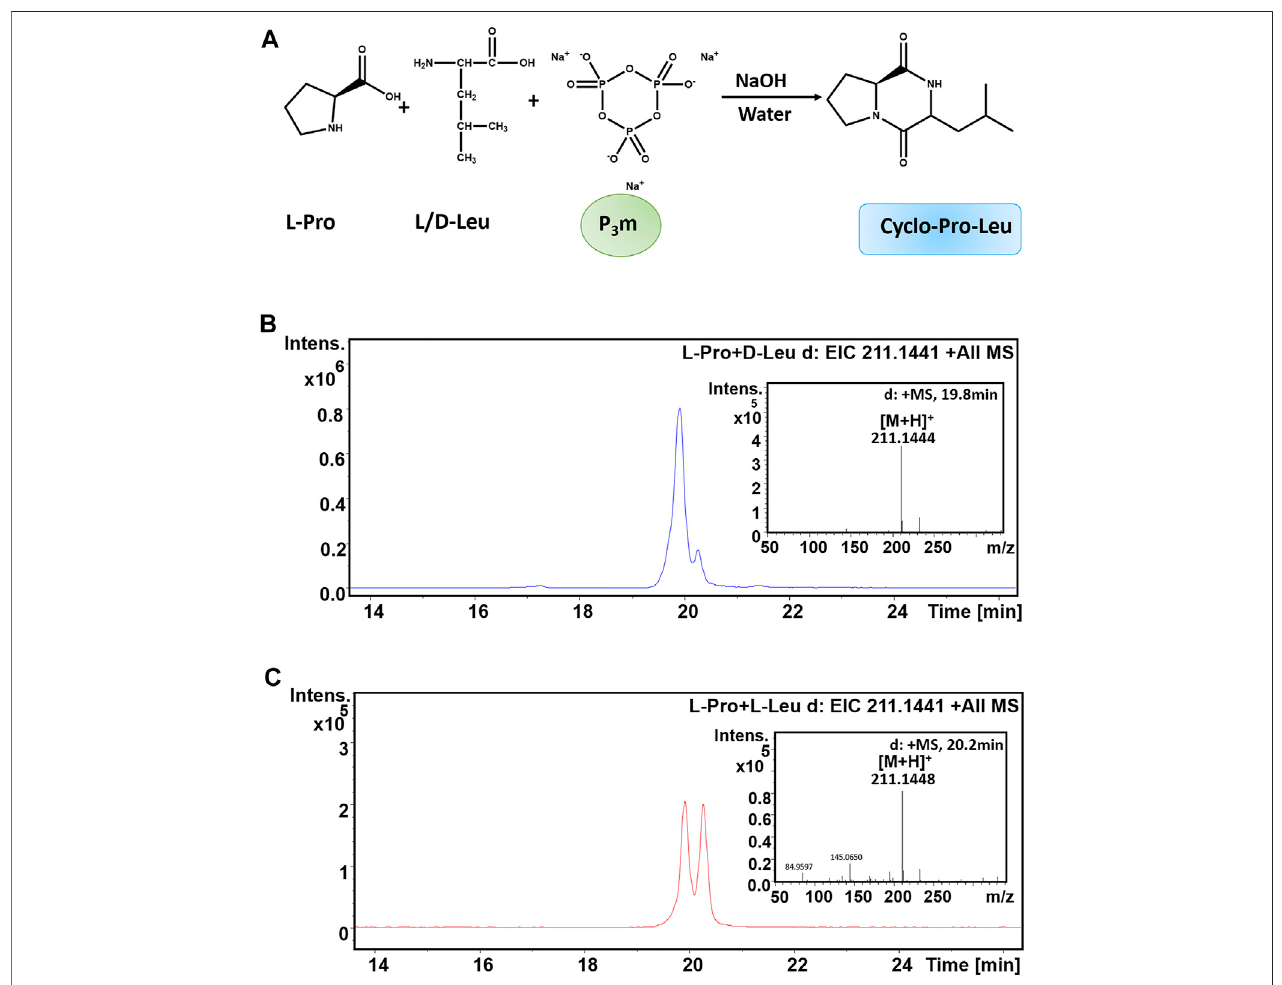
FIGURE 1 | Formation of cyclo-L-Pro-Leu from a reaction mixture of L-Pro, L/D-Leu and P 3 m in an alkaline aqueous solution (pH = 11.7). The calculated value of cyclo-Pro-Leu [M + H] + is 211.1441. (A) Reaction scheme. (B) EIC-MS spectrum of the cyclo-L-Pro-L-Leu from the L-Pro reaction with L-Leu. (C) EIC-MS pro fi le of the cyclo-L-Pro-D-Leu from the L-Pro reaction with D-Leu.